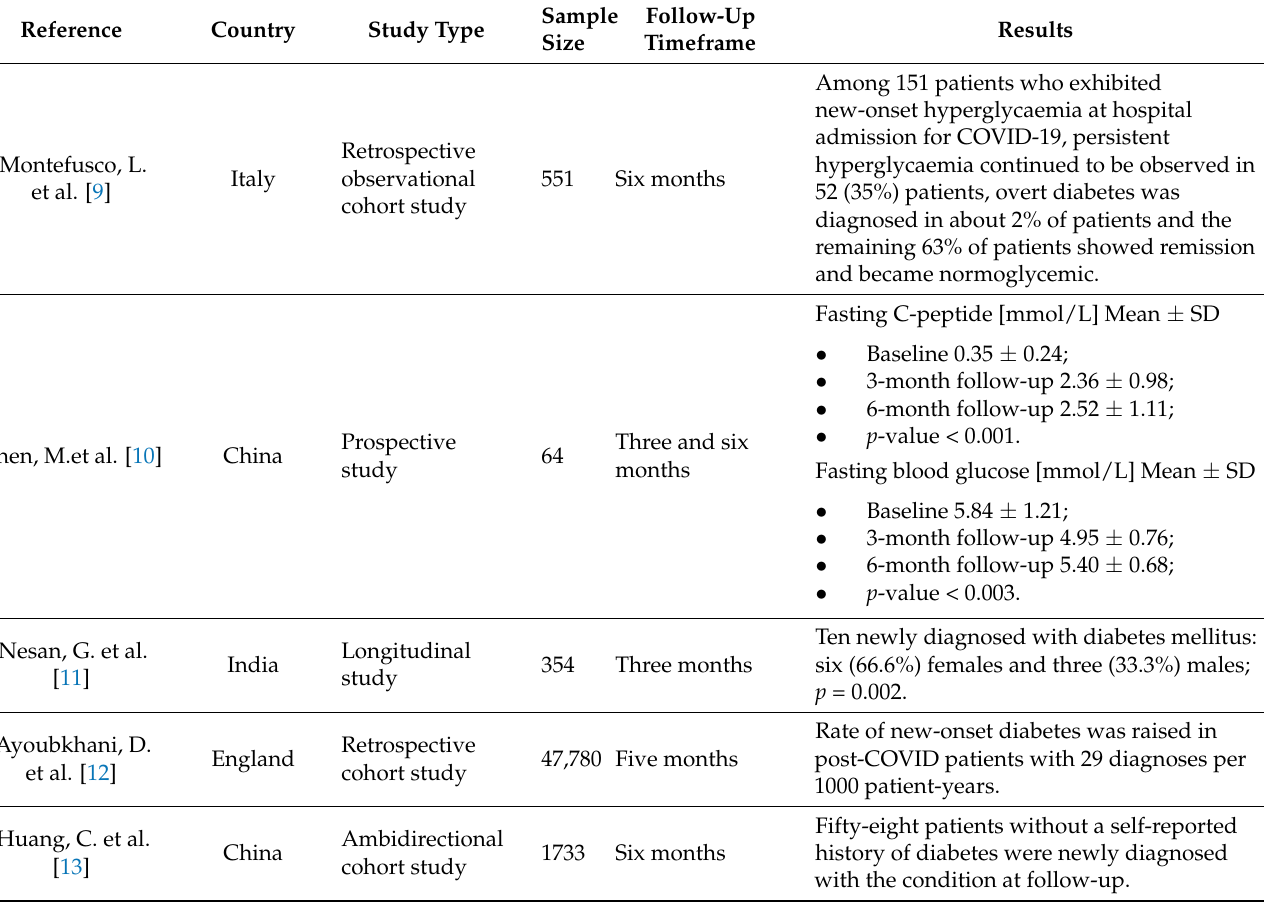
Table 1. Summary of studies investigating new-onset diabetes mellitus after COVID-19